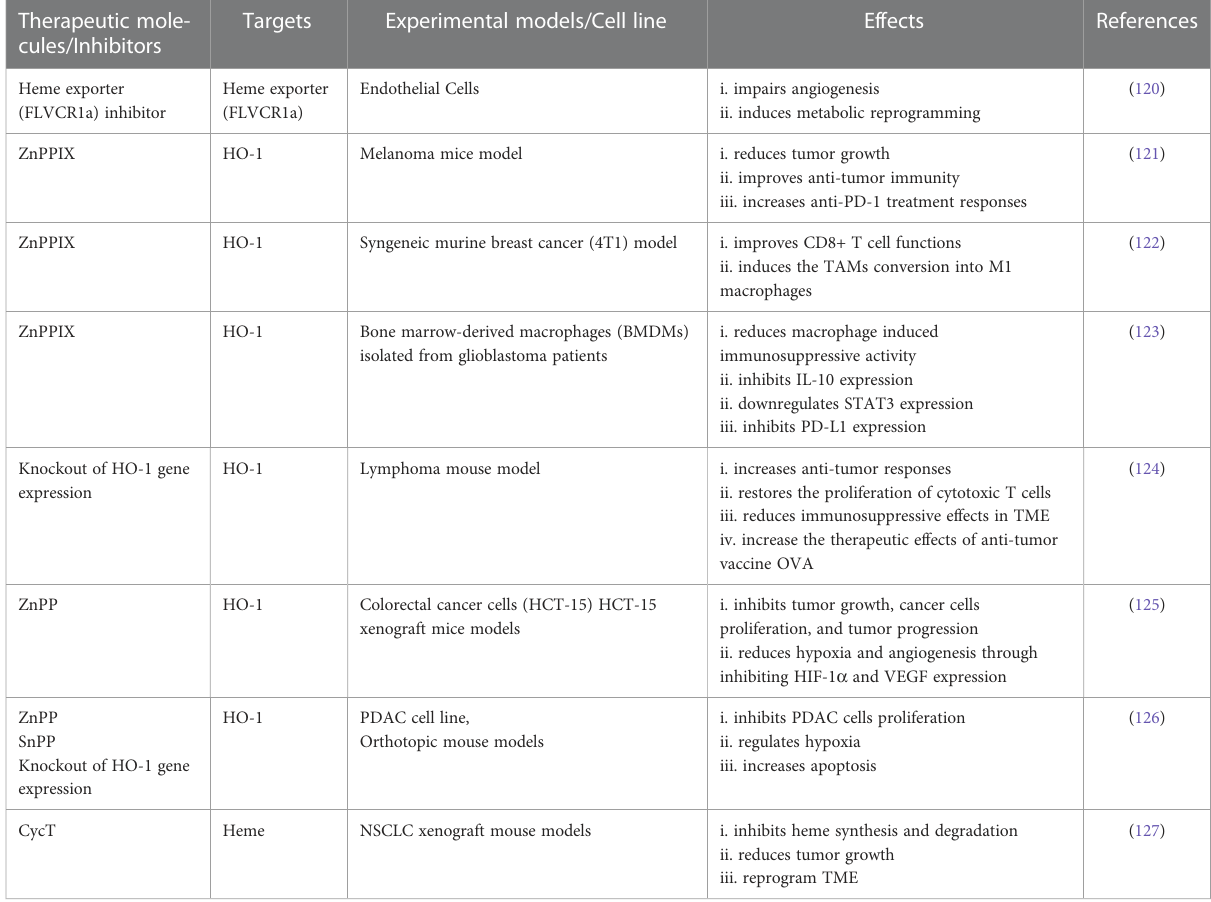
TABLE 1 Studies targeting heme and heme catabolism and their effects in TME and anti-tumor immunity. Therapeutic